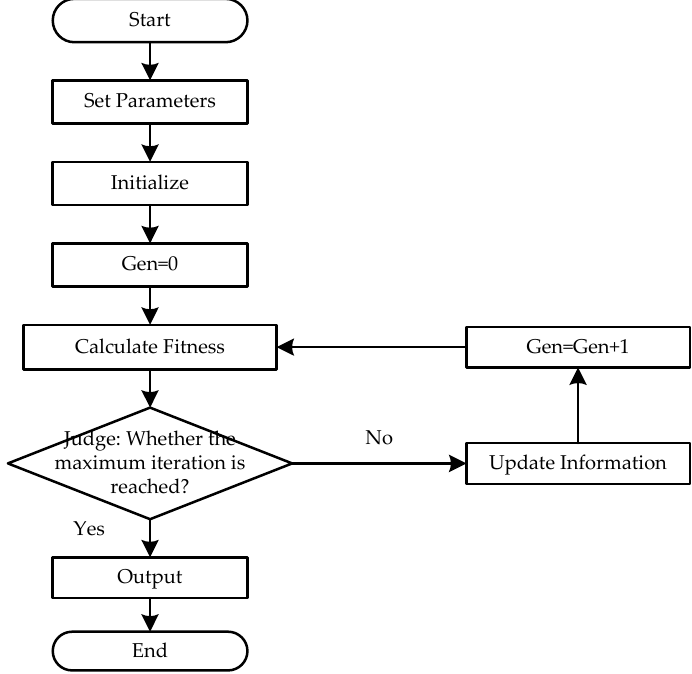
Figure 8. Flowchart of optimization algorithm.